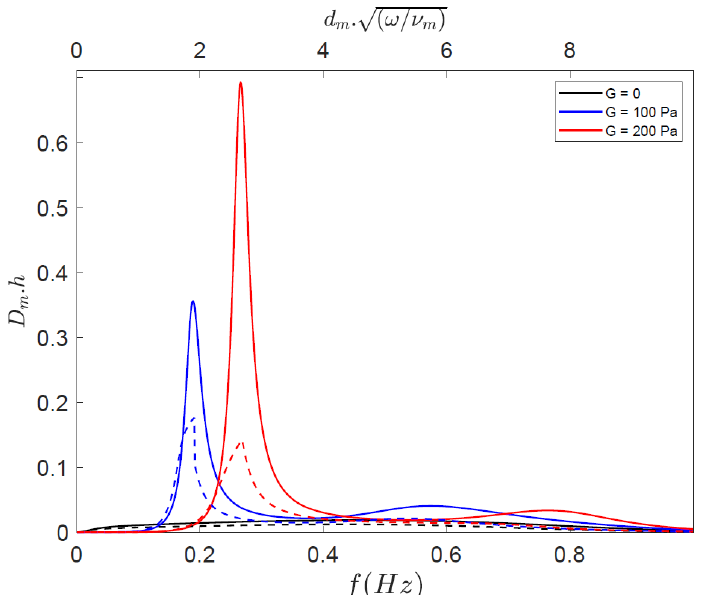
Figure 14. Variation of surface wave damping rate with frequency for mud with shear moduli G = 0, 100 and 200 Pa. Solid line: LC model, dashed line: Macpherson [17], ζ = 100, h = 0.8 m, d m = 0.4 m, and ρ m = 1111 kg/m 3